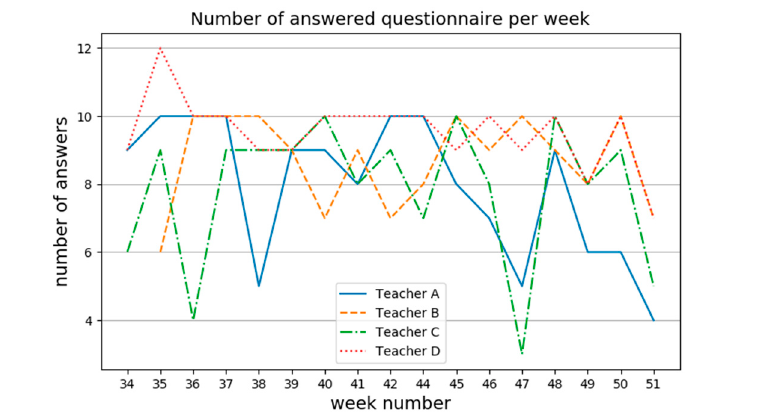
Figure 2. Number of answered questionnaires per week for each teachers